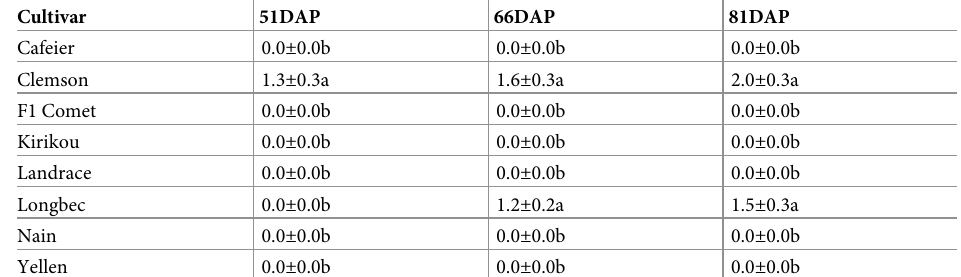
Table 15. Severity of powdery mildew on okra